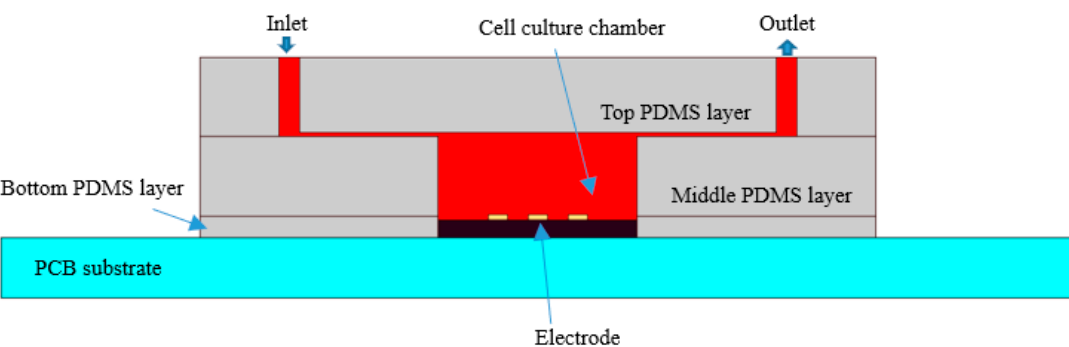
Figure 3. Schematic of microfluidic channels with cross section of closed culturing chamber (drawing not to scale).